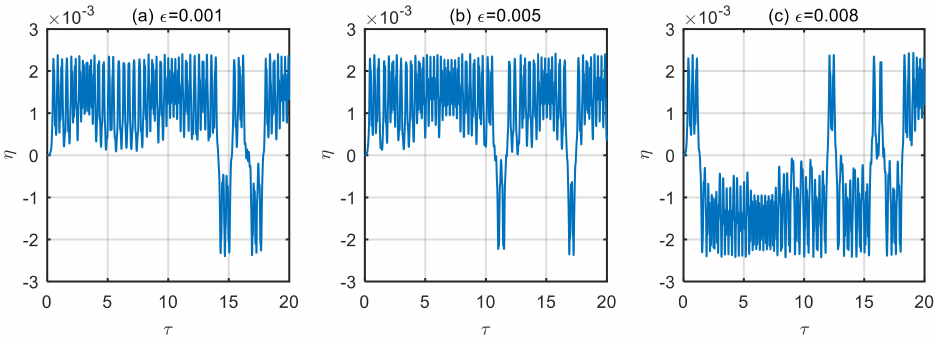
Figure 5. Displacement time history diagram ( a ) and phase diagram ( b ) of microtubes with different dimensionless amplitude of the excitation loads ( u = 3).